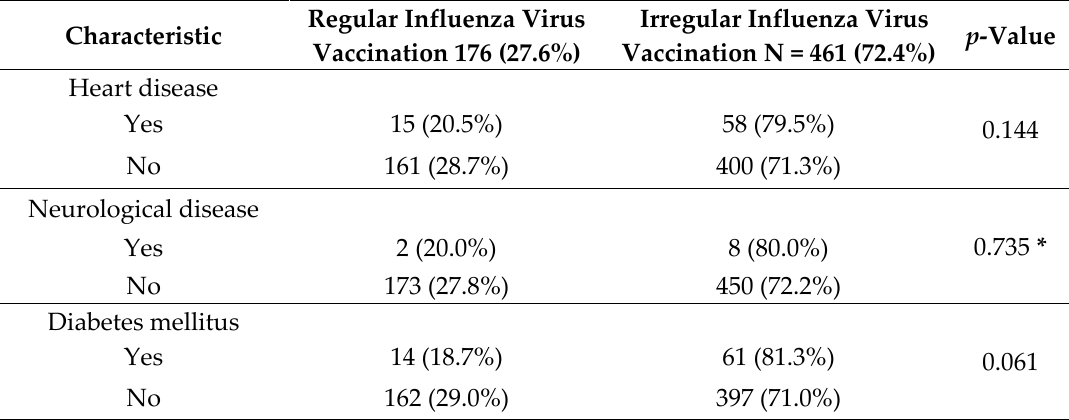
Table 3. Chronic disease conditions and influenza